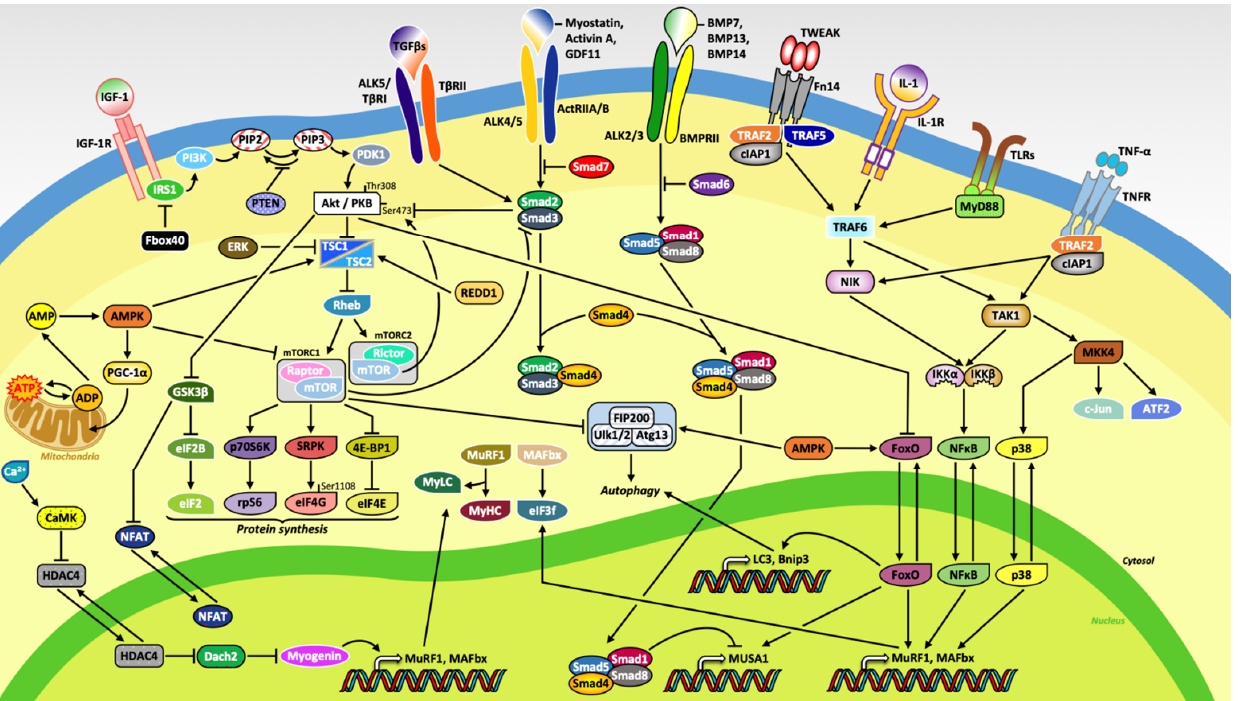
Figure 1. Schematic representation of the molecular mechanisms regulating skeletal muscle mass. Binding of insulin-like growth factor-1 (IGF-1) to its putative receptor (IGF-1R) induces protein synthesis primarily through downstream activation of Akt/PKB and mTOR. The myostatin/activin A/growth differentiation factor 11 (GDF11) and transforming growth factor beta (TGF β ) pathways inhibits muscle growth due to the phosphorylation of Smad2/3, which serves a primary function as an inhibitor of Akt. The ubiquitous protein kinase complex mammalian target of rapamycin complex 1 (mTORC1) stimulates protein synthesis through activation of the 70-kDa ribosomal protein S6 kinase (p70S6K) and its substrate ribosomal protein S6 (rpS6), the serine/arginine-rich protein specific kinase SRPK, and the translation repressor protein called eukaryotic translation initiation factor 4E (eIF4E)-binding protein 1 (4E-BP1), also known as PHAS-1. Moreover, increased in cellular concentration of adenosine monophosphate (AMP) stimulates AMP-activated protein kinase (AMPK) as well as peroxisome proliferator–activated receptor gamma coactivator-1 alpha (PGC-1 α ) to induce mitochondrial biogenesis. Extracellular signaling molecules, bone morphogenic protein (BMP) 7, 13, and 14, and inflammatory cytokines tumor necrosis factor (TNF)-like weak inducer of apoptosis (TWEAK), interleukins (ILs), and tumor necrosis factor alpha (TNF- α ) increased expression of genes related to the ubiquitin-proteasome system (UPS) and autophagic-lysosomal pathway